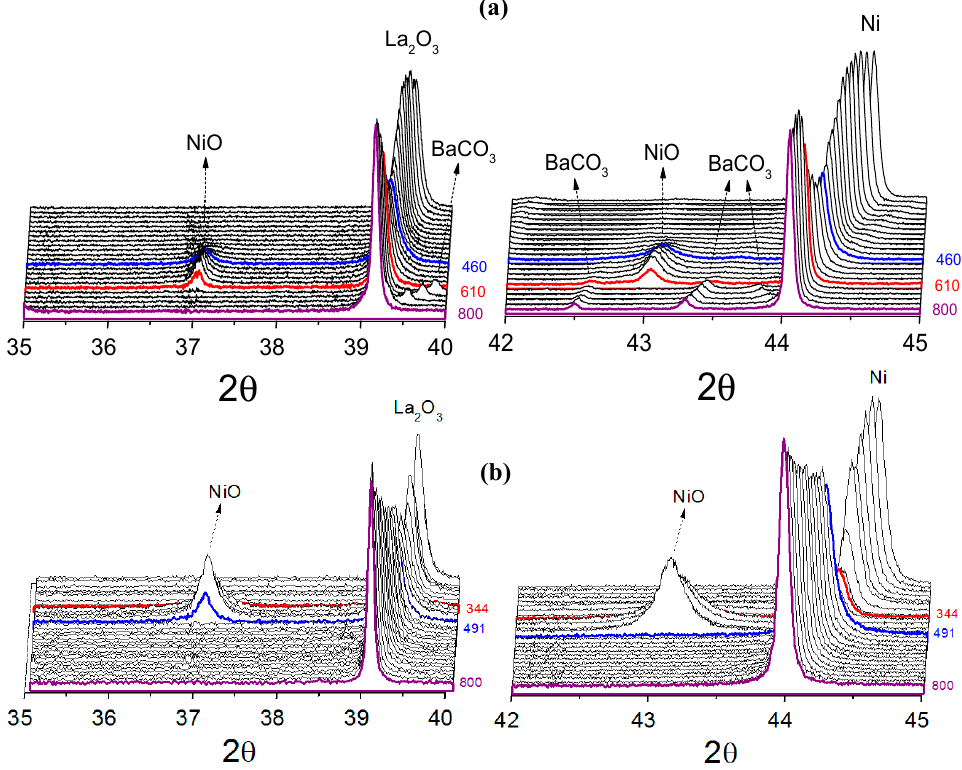
Figure 4. X-ray diffractograms for the catalysts under reaction atmosphere. ( a ) La 0.8 Ba 0.2 NiO 3 (upper panels) and ( b ) NiO/La 2 O 3 (bottom panels).